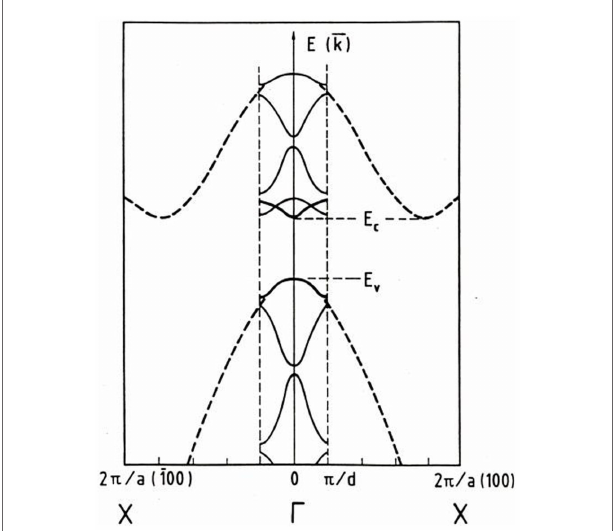
FiGURe 2 | Schematic representation of the Brillouin zone-folding concept in Si resulting from the new superlattice periodicity in the growth direction . Here, the conduction band minimum along the X direction is folded back into the Г point when the superlattice period is about 10 monolayers of Si (Kasper and Schäffler,